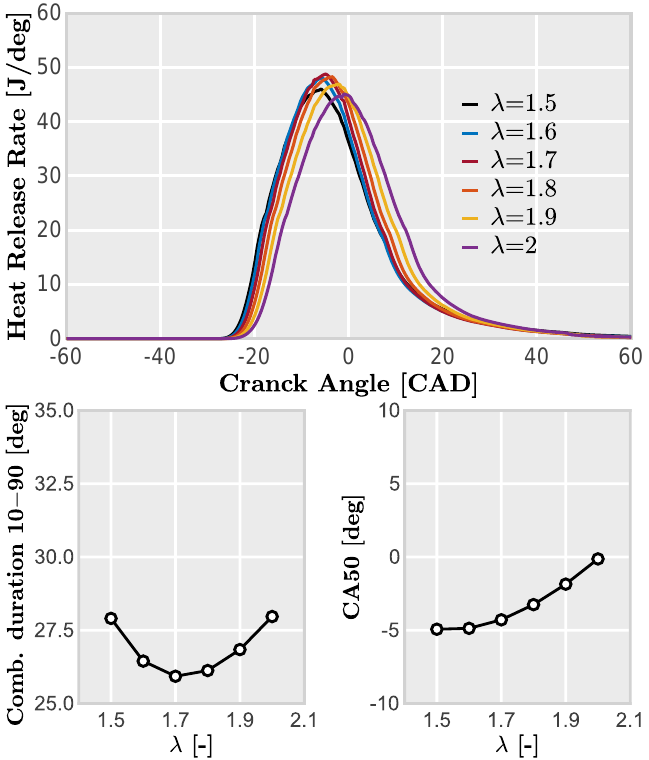
Figure 15. Trends of the main characteristics of the combustion process. Heat release rate profiles ( top ), combustion duration ( bottom-left ), and combustion phasing ( bottom-right ) for different air- to-fuel ratios considering hydrogen